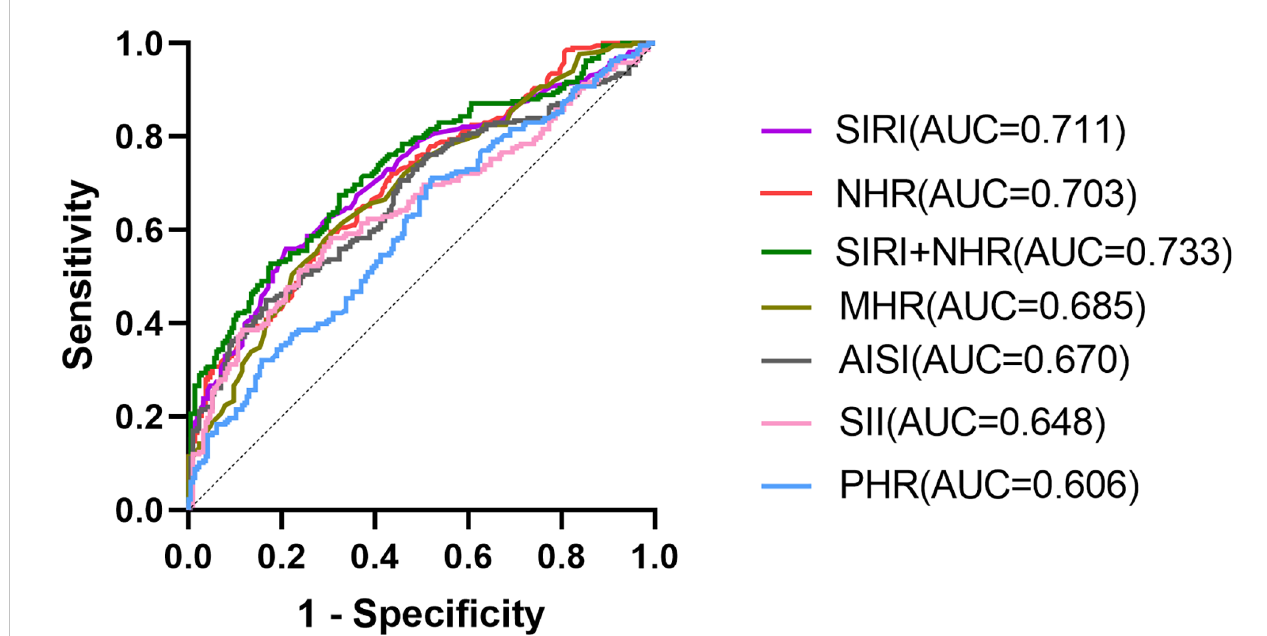
FIGURE 2 ROC curve analysis of the ability of these biomarkers to predict T2DM – PAD. SIRI (AUC 0.711, 95% CI:0.663 – 0.760, P = 0.000, cut-off 0.95, sensitivity 56%, speci fi city 79.2%); NHR (AUC 0.703, 95% CI:0.655 – 0.751, P = 0.000, cut-off 3.44, sensitivity 59.6%, speci fi city 69.4%); SIRI+NHR combined model (AUC 0.733, 95% CI:0.686-0.779, P = 0.000, cut-off 0.57, sensitivity 52.8%, speci fi city 82.4%); MHR(AUC 0.685, 95% CI:0.636 – 0.735, P = 0.000, cut-off 0.33, sensitivity 61.0%, speci fi city 70.4%);AISI(AUC 0.670, 95% CI:0.619 – 0.721, P = 0.000, cut-off 218.94, sensitivity45%, speci fi city83.3%);SII(AUC 0.648, 95% CI:0.596 – 0.700, P = 0.000, cut-off 486.96, sensitivity58.3%, speci fi city 69.4%);PHR (AUC 0.606, 95% CI:0.553 – 0.658, P = 0.000, cut-off 166.47, sensitivity71.1%, speci fi city